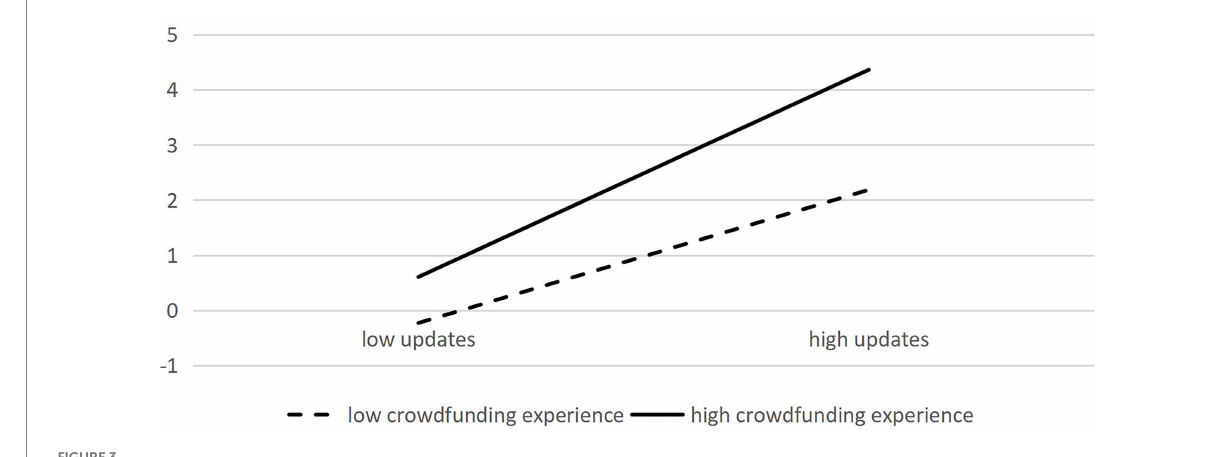
FIGURE 3 Moderating effect of crowdfunding experience on update quantity and crowdfunding success.